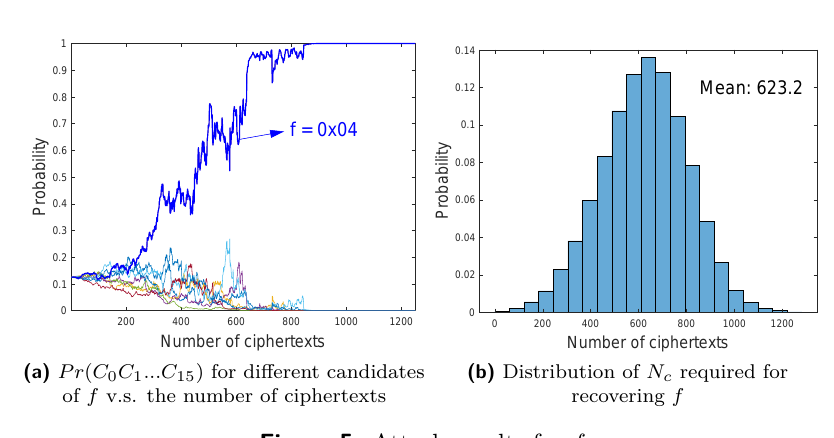
(b) Distribution of N c required for recovering f Figure 5: Attack results for f